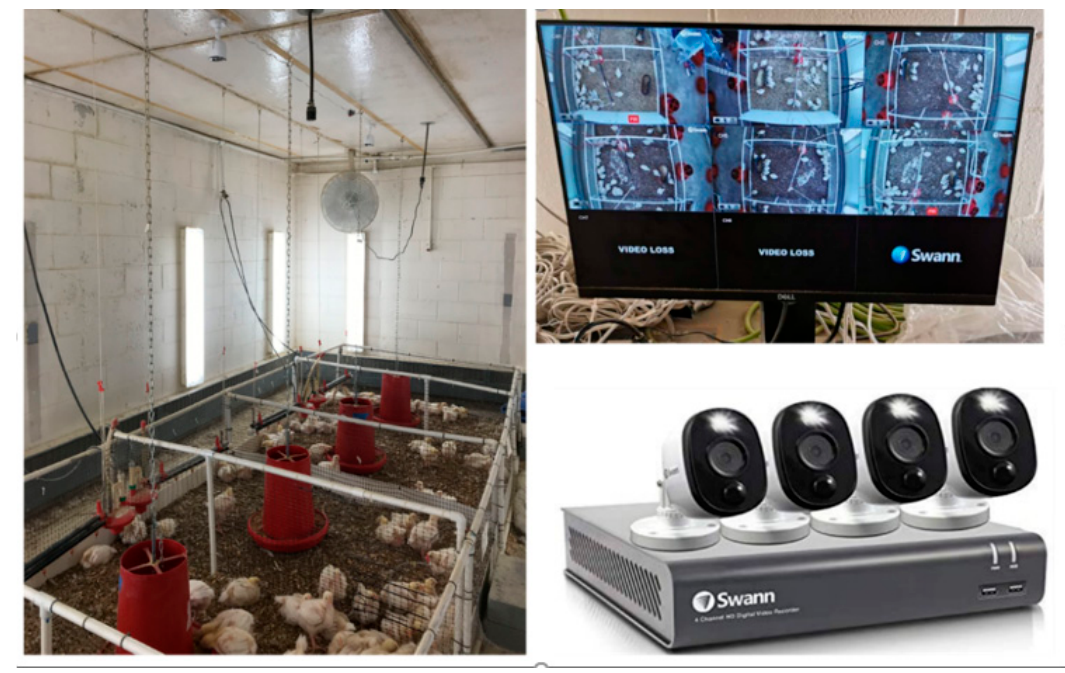
Figure 1. Experimental setup for broiler chicken image data collection.